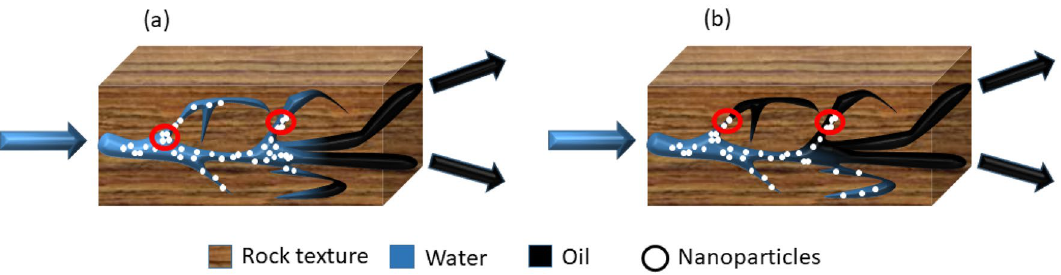
Fig. 3 Schematic illustration of log jamming ( a ) and pore plugging ( b